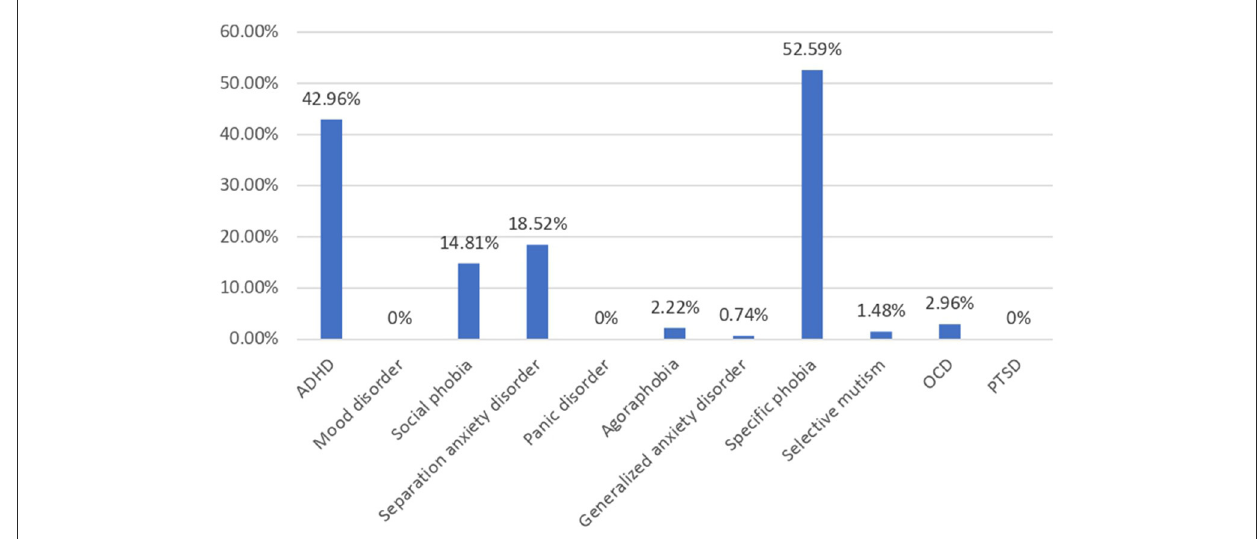
FIGURE1 Prevalence of psychiatric comorbidities in austim group ( n =